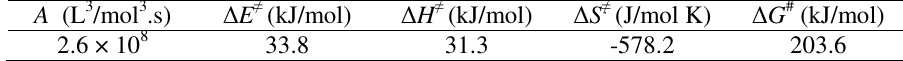
Table 2. Activation parameters for the decolorization of methyl orange reaction at 25°C A (L 3 /mol 3 .s)